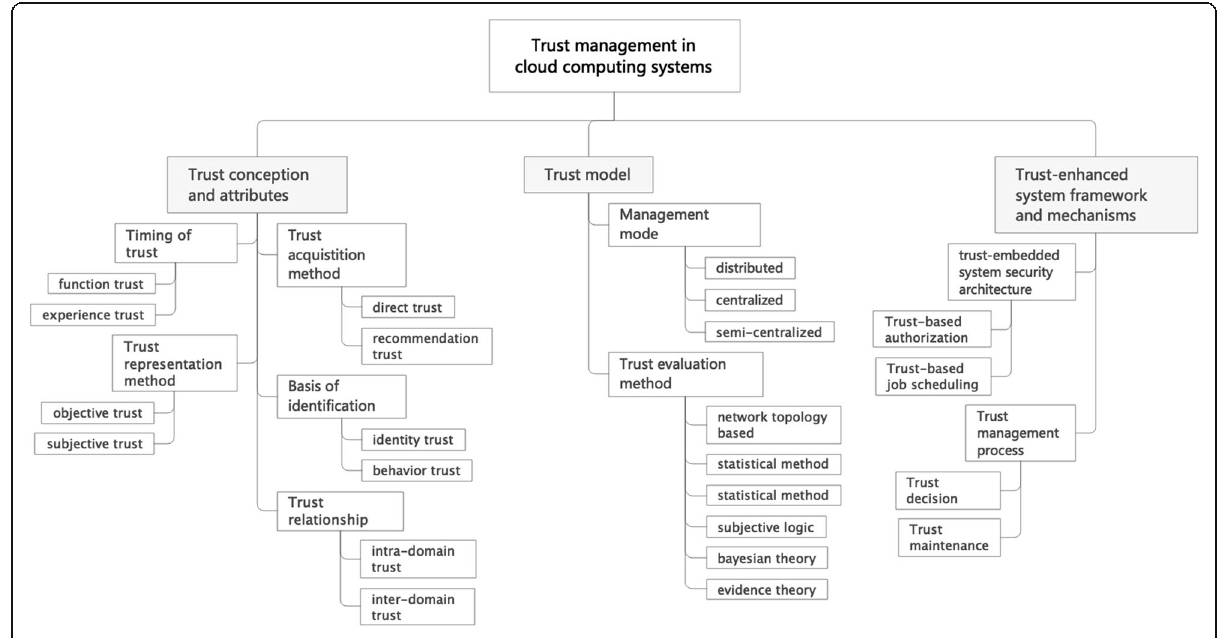
Fig. 1 Trust management in cloud computing systems